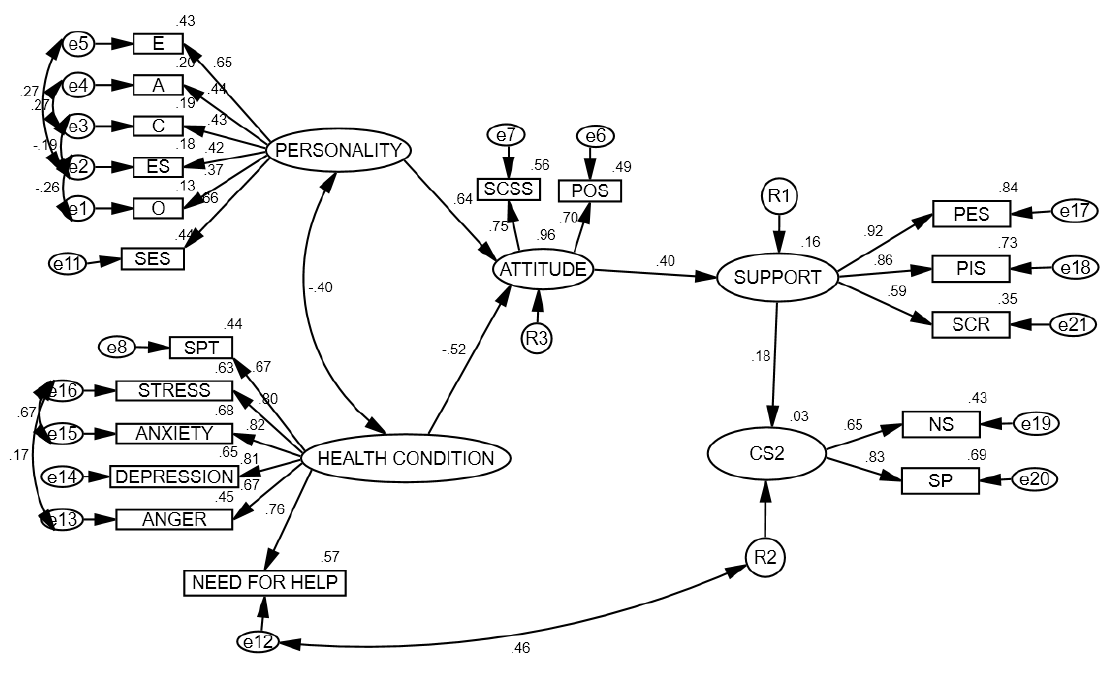
Figure 2. Model of social support for cancer patients during cancer treatment. E—Extraversion, A—Agreeableness, C—conscientiousness, ES—Emotional Stability, O—Openness to Experience, SES—Rosenberg Self-Esteem Scale, SPT—Social Pain Thermometer, SCSS—State Self-Compassion Scale, POS—Positive Orientation Scale, PES—Perceived Emotional Support, PIS—Perceived Instrumental Support, SCR—Support Currently Received, NS—Need for Support, SP—Sense of Support, CS2—Complementary